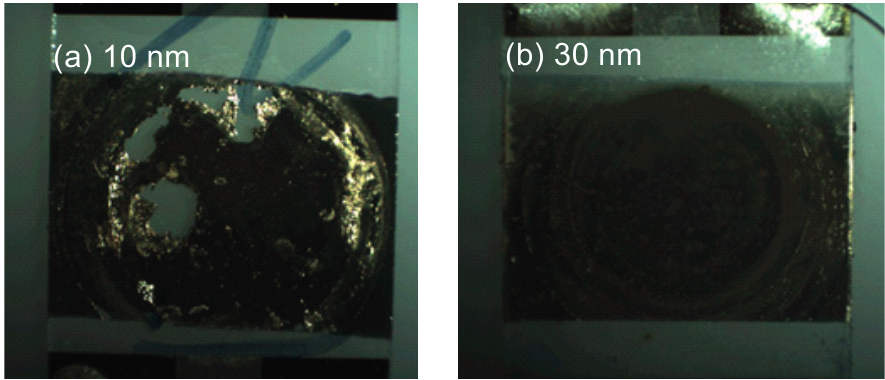
Figure 6. Microscopic images of the gold layers ( a ) 10 nm; ( b ) 30